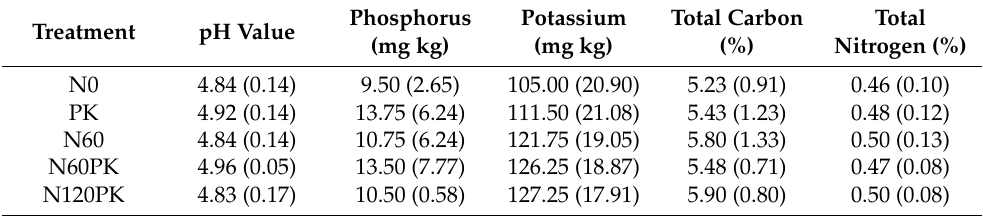
Table 1. Mean and standard deviation (in brackets) of soil chemical characteristics (sampling depth 0–10 cm) before the experiment